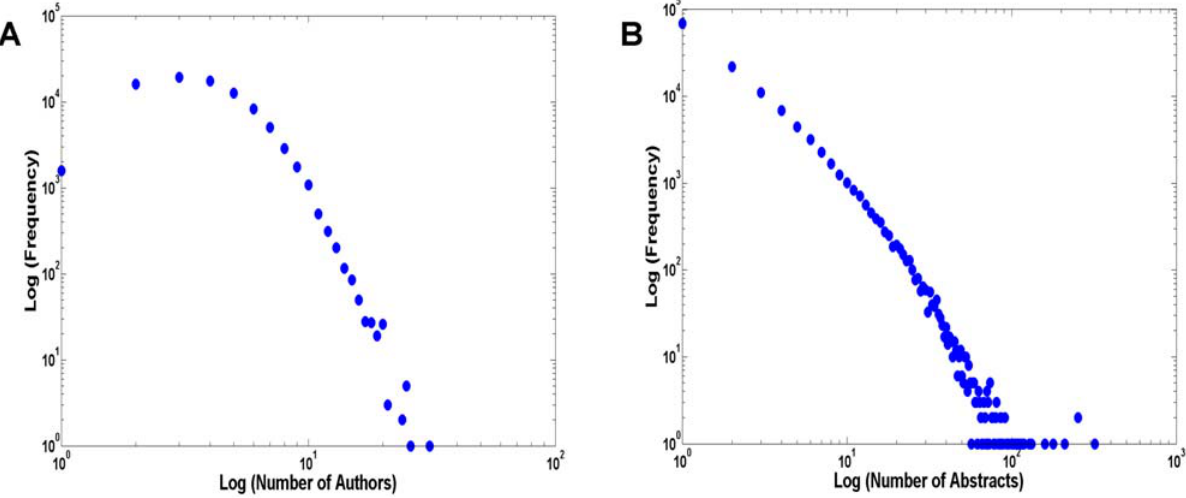
Figure 4. (A) Histograms of the average number of authors per abstract between 2001 and 2006. (B) Histograms of the average number of abstracts per author between 2001 and